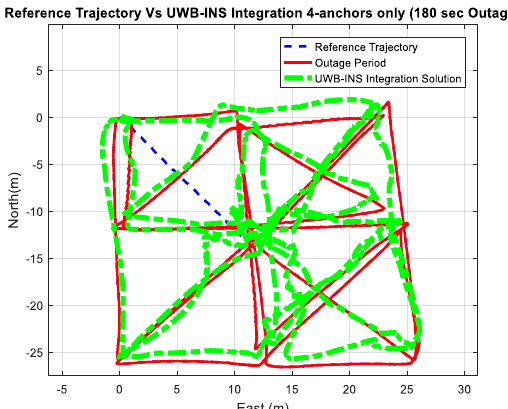
Figure 13. The solution from UWB system alone with lower infrastructure (configuration f )